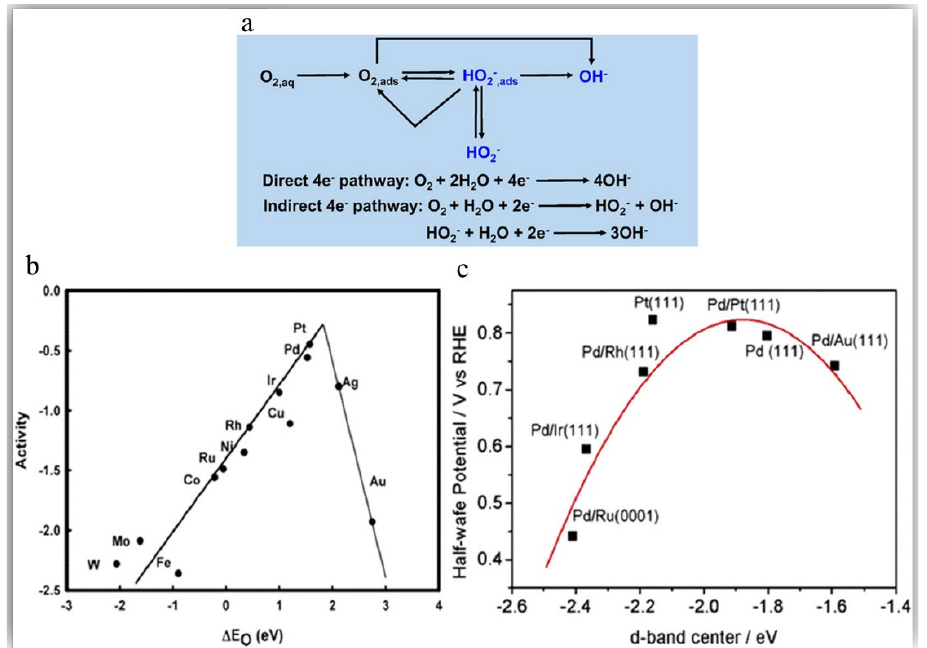
Figure 3. Schematic diagram of ORR mechanism in alkaline system. ( a ) direct 4e − and 2e − pathways [54], reprinted with permission from Ref. [54]. Copyright © 2022 John Wiley and sons. ( b ) Variation trend of ORR activity with oxygen binding energy [31], reprinted with permission from Ref. [31]. Copyright © 2004 American Chemical Society. ( c ) Volcano plot of half-wave potential and d-band center versus Fermi level [56]. Reprinted with permission from Ref. [56]. Copyright © 2006 American Chemical Society.